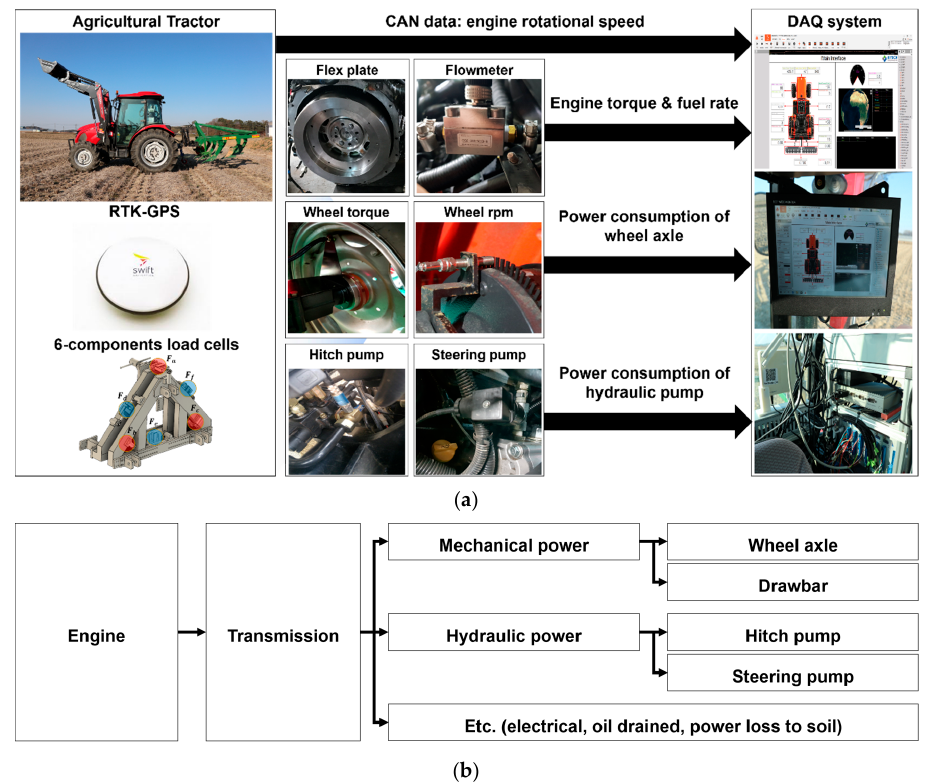
Figure 3. ( a ) Configuration of the load measurement system and ( b ) power flow diagram for 42 kW power agricultural tractor used in this experiment.